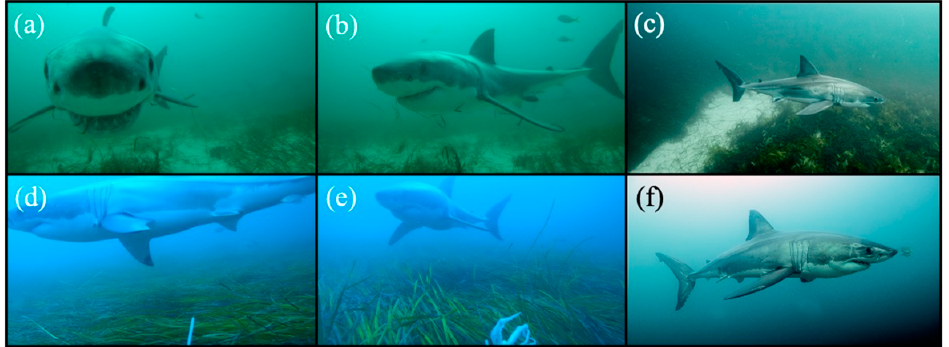
Figure 3. Examples of young-of-the-year (YOY) and juvenile white shark ( Carcharodon carcharias ) interactions on the baited remote underwater video systems (BRUVS; a – e ) and the BlueROV2 ( c , f ). These images were captured at Daw Island, Western Australia—33°51 ′ S, 124°08 ′ E.